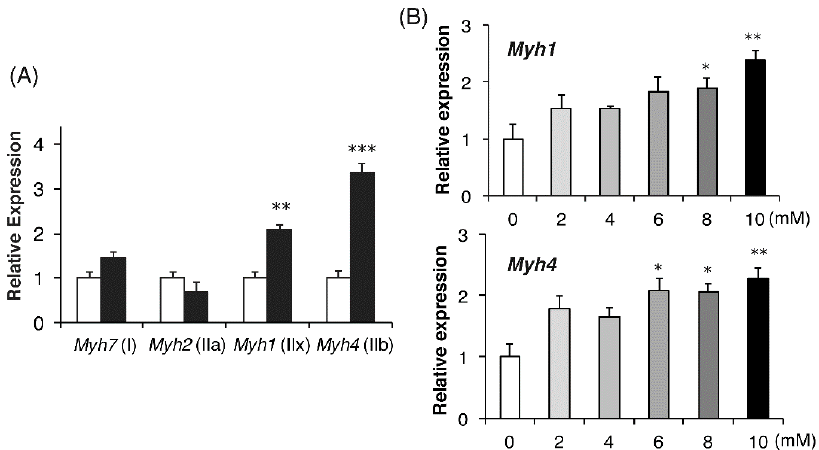
Figure 4. Lactate increased mRNA expression of predominantly the fast MHC isoform in C2C12 myotubes. ( A ) Cells were differentiated in control medium (open bar) or medium containing 10 mM sodium lactate (closed bar) for 5 d. Gene expression levels of Myh7 , Myh2 , Myh1 , and Myh4 , encoding MHC subtypes I, IIa, IIx, and IIb, respectively, were determined. Values are expressed as the fold changes, compared with each control ( n = 4 per group). ** p < 0.01 versus the control. ( B ) Differentiation was induced in medium containing the indicated concentration of lactate. Cells were harvested on day 5 and expression levels of Myh1 and Myh4 were determined. Values are expressed as fold changes compared with the level in the 0 mM group ( n = 4 per group). Results are expressed as mean ± SE. * p < 0.05, ** p < 0.01, *** p < 0.001, versus the 0 mM group.